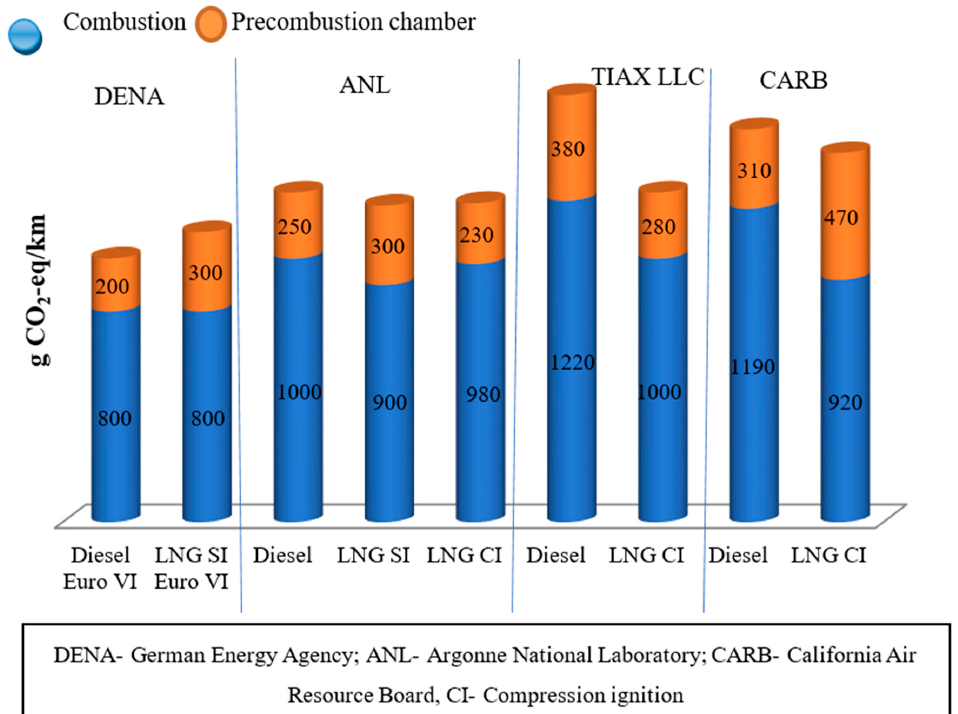
Figure 3. Life cycle greenhouse gas comparison of diesel and LNG heavy-duty vehicle (adapted from [40]). Note: Permission granted from the publisher (Elsevier-Renewable and Sustainable Energy Reviews).